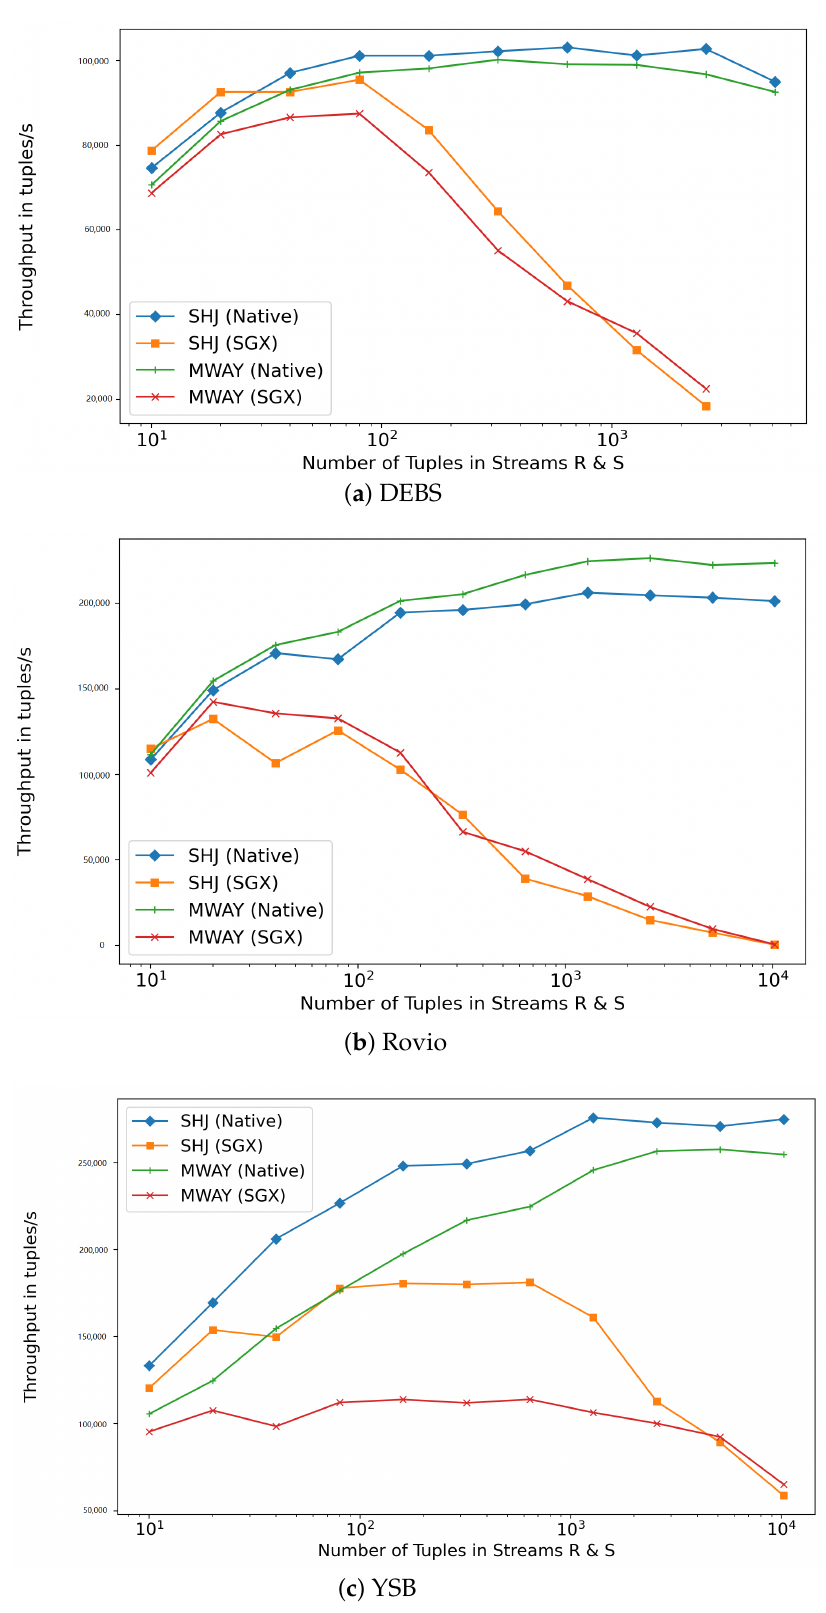
Figure 6. Average Throughput with Different Processing